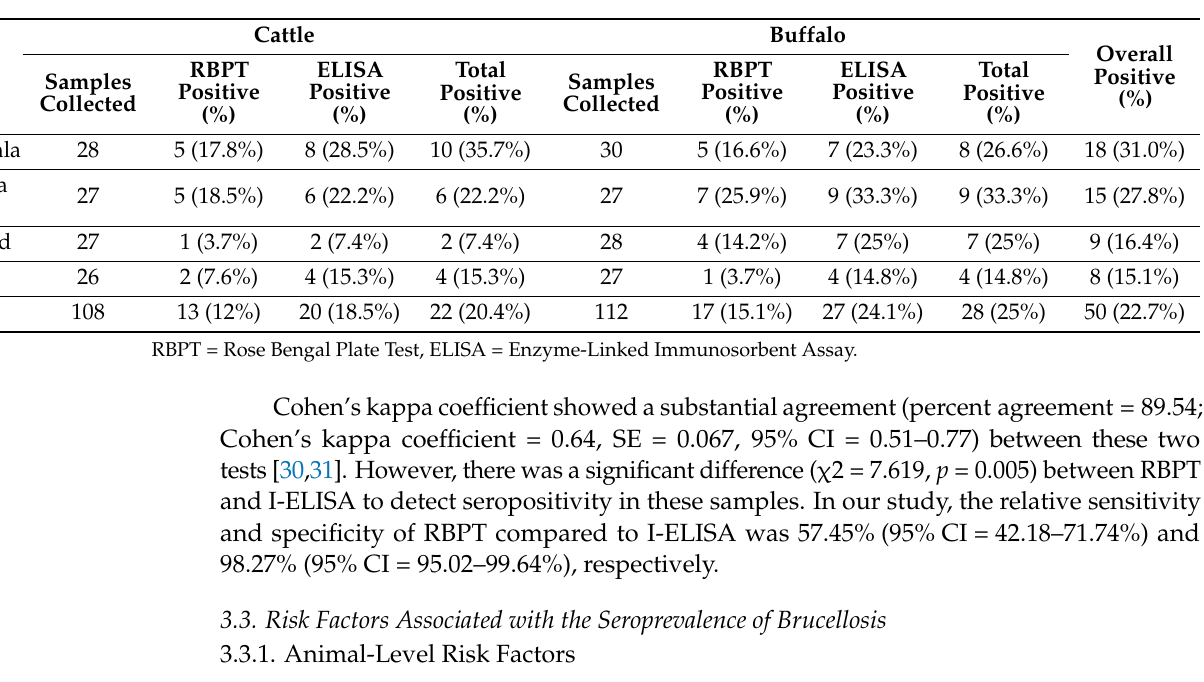
Table 1. Seroprevalence of brucellosis in bovines using a parallel diagnostic approach in Gujranwala District, Pakistan.